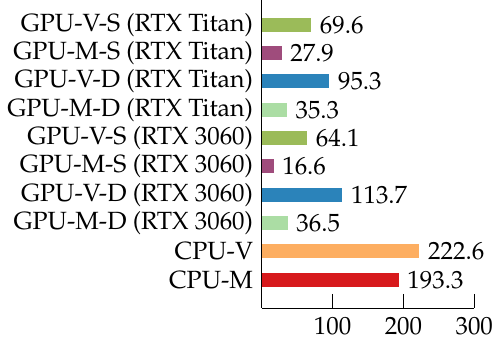
Figure 9. Comparison between the computation times ( × 10) obtained for propagation in open free space at 20.00